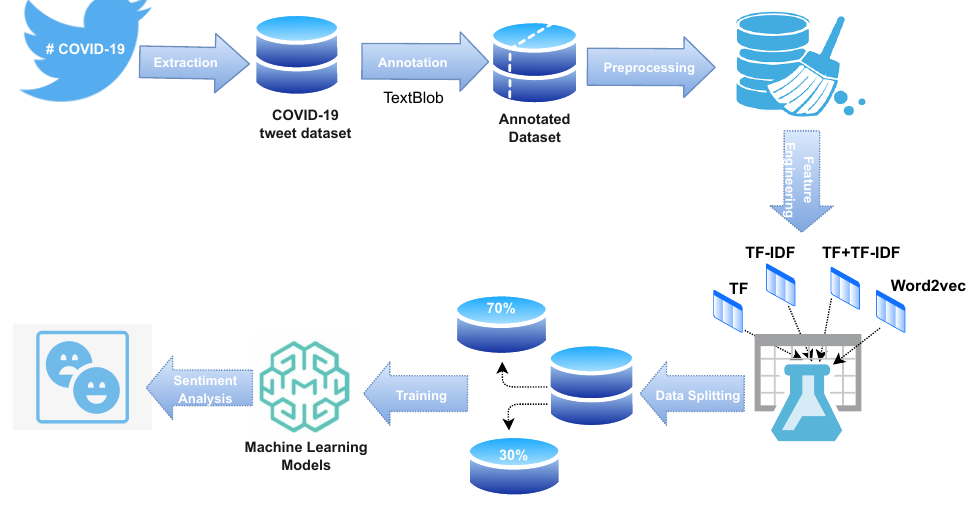
Figure 2. Workflow diagram of the proposed VC(ETC+CNN) architecture